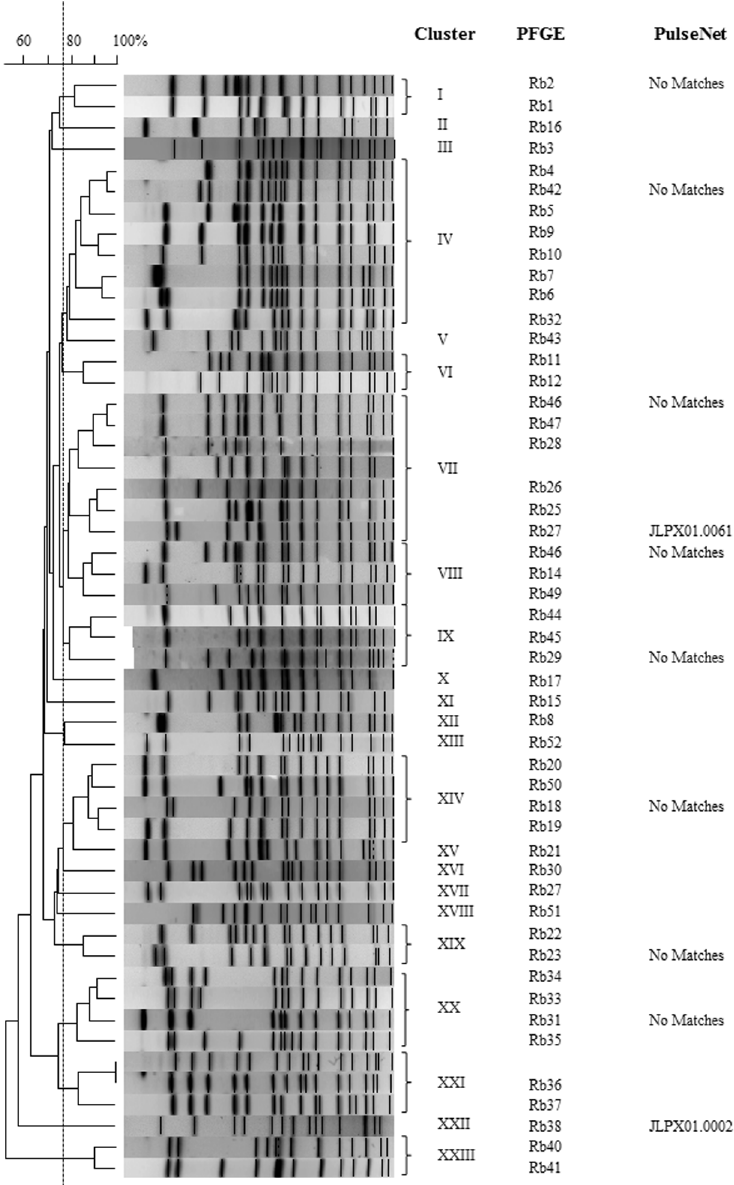
Fig 4. Dendrograms of representative Salmonella PFGE patterns for Salmonella serovars Rubislaw collected from Oconee and Little River Basins and archived isolates with similar PFGE profiles. Vertical line indicates 75%